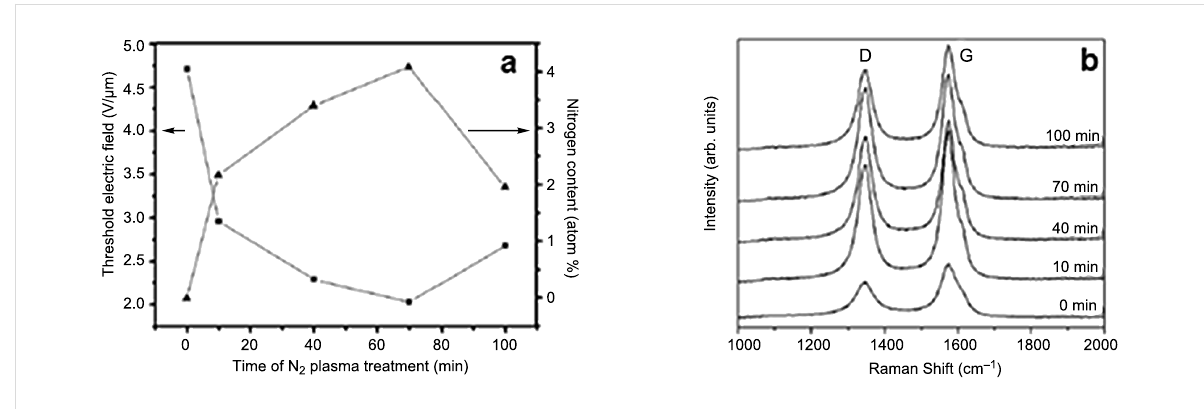
Figure 12: (a) Variation of threshold electric field and nitrogen content with the duration of the nitrogen plasma treatment. (b) Raman spectra of the CNTs after different times of nitrogen plasma treatment. Adapted with permission from [109]. Copyright 2009 Elsevier.